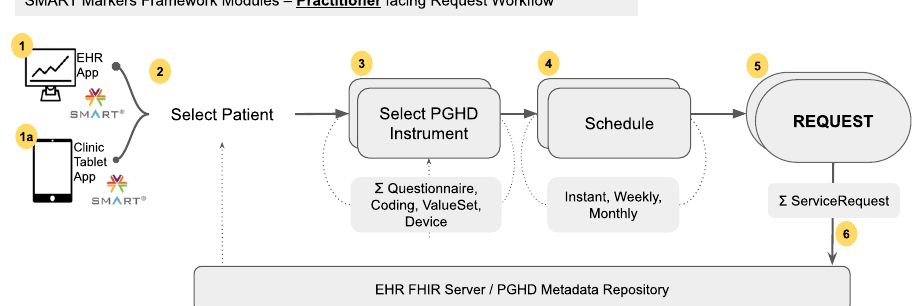
Fig. 3 SMART Markers framework modules for practitioner-facing apps interacting with a SMART enabled EHR FHIR Server. Data Flow is shown: The practitioner: (1,1a) launches the app at point of care. (2) selects a patient. (3) the app compiles a list of PGHD instruments from the EHR/PGHD FHIR repository. (4) the practitioner selects a schedule for the request. (5) A FHIR ServiceRequest is generated per instrument. (6) Requests are submitted to FHIR